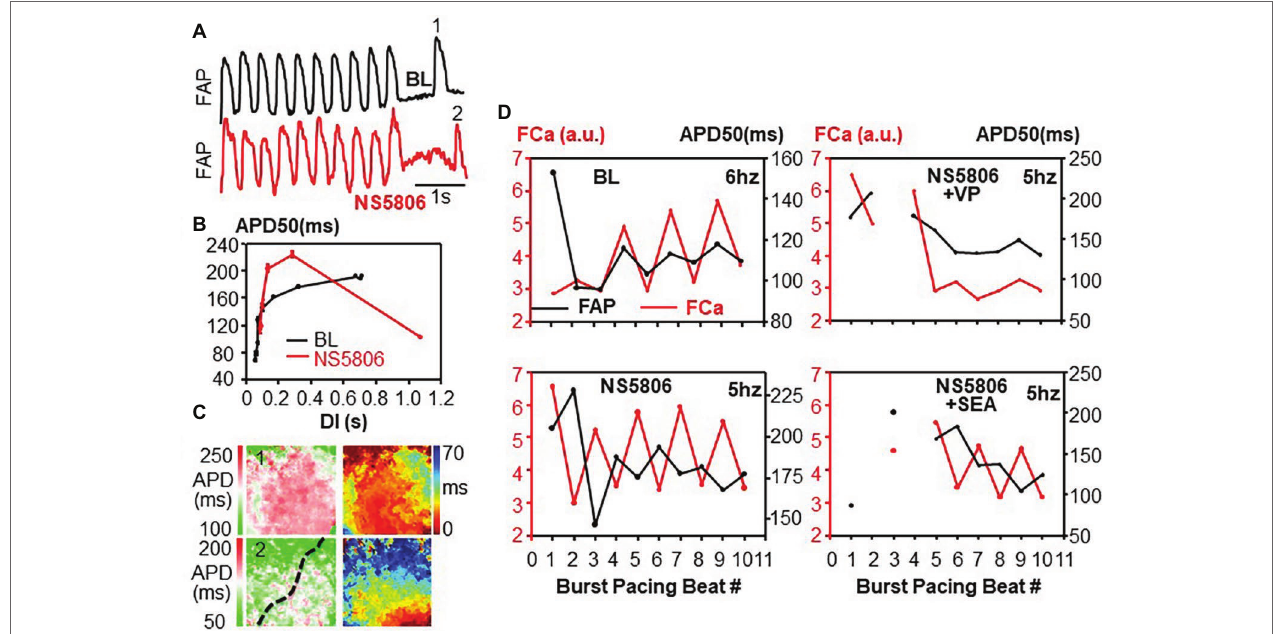
FIGURE 4 | APD rate adaptation. An example of pause-dependent APD shortening during NS5806 infusion (A) , APD restitution curves (B) , and APD and isochronal map (C) for long DI beats (beat 1 at BL and beat 2 after NS5806). Dotted line marks location of left anterior descending artery. During NS5806 infusion, APD shortening – rather than prolongation – was noted following very long (>1 s) pauses after pacing bursts. (D) Phase diagrams of Ca and APD at BL and under different drugs. In BL control conditions, the first paced beat following a long DI had a long APD. Subsequent paced beats led to APD and Ca alternans, most commonly in phase (AP/Ca concordant). During NS5806 infusion, the first paced beat following a long DI had a short APD, while the Ca transient had normal rate- dependence and was large after long DIs. Thus, the short first APD had still a large Ca transient, which led to APD/Ca alternans discordance after NS5806 administration. NS5806-induced AP/Ca-discordant alternans was unaffected by SEA, but was eliminated by